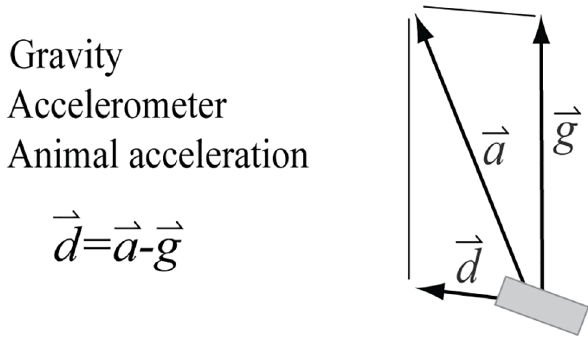
Fig 1. The measured accelerometer vector is the vector sum of gravity and dynamic tag acceleration. * g ) is often called static acceleration, a constant at 9.8 m/s 2 at the earth ’ s surface. Acceleration due to gravity ( * d ). For large animals, accelerations of an Accelerations of an animal due to animal movements are dynamic ( animal ’ s mass due to locomotion tend to be substantially smaller than g, except for brief intervals. The * * * a ) is the vector sum of d and g measured acceleration (